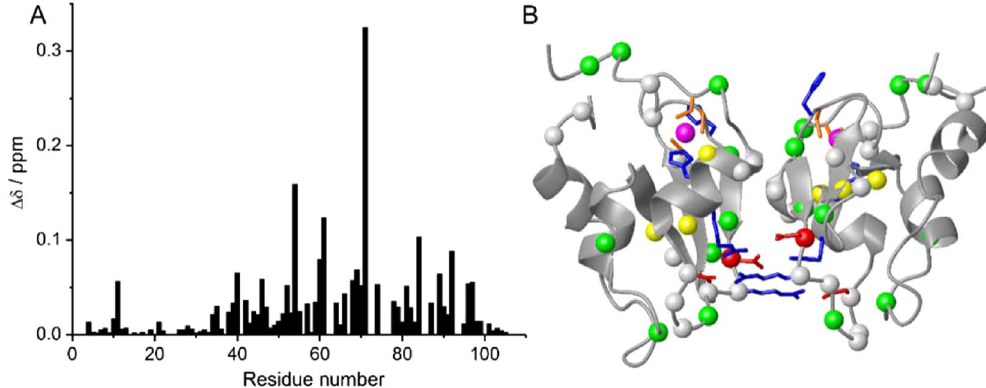
Figure 2. Chemical shift perturbations of D71N/R72E mutant on BIR1. ( A ) Plot of chemical shift perturbations caused by D71N/R72E mutation on BIR1 with the function of amino acid sequence. The chemical-shift differences between WT and D71N/R72E BIR1 were calculated as δ = (( Δδ H ) 2 + ( Δδ N /10) 2 ) 1/2 . ( B ) Chemical shift differences between WT BIR1 and D71N/R72E mutant plotted on the dimeric structure of BIR1 (PDB code: 2QRA) 13 , of which the C α atoms are shown in red spheres with δ > 0.2 ppm, yellow spheres with 0.1 < δ ≤ 0.2 ppm, green spheres with 0.05 < δ ≤ 0.1 ppm, respectively. The unassigned C α resonances in WT BIR1 were shown in grey spheres.